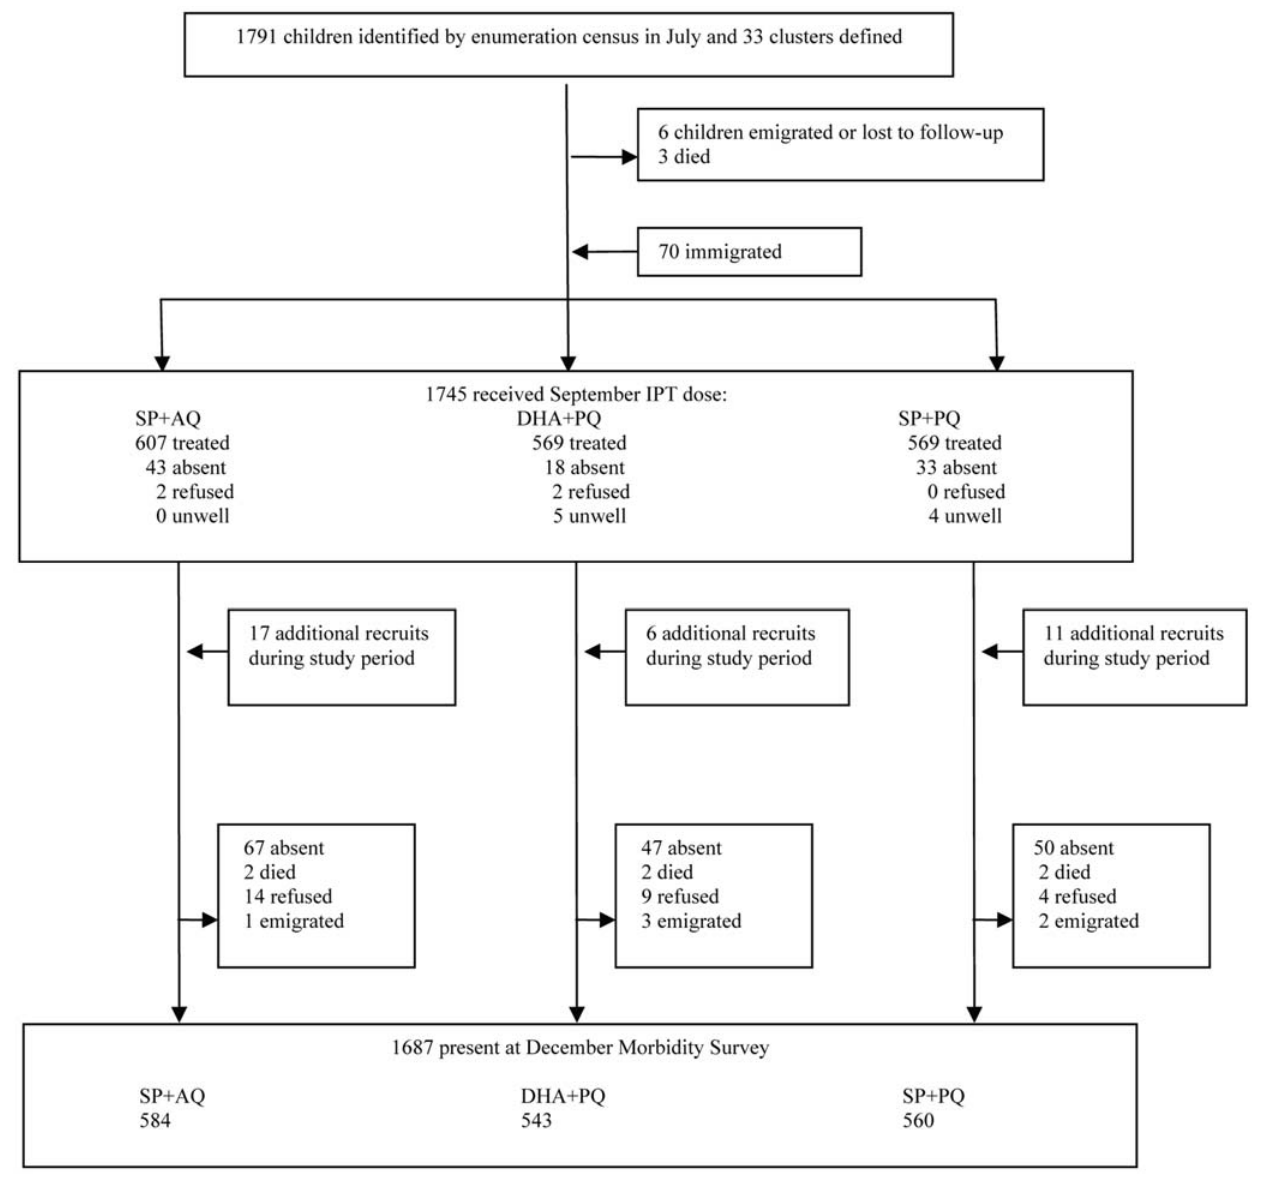
Figure 1. Trial Profile.